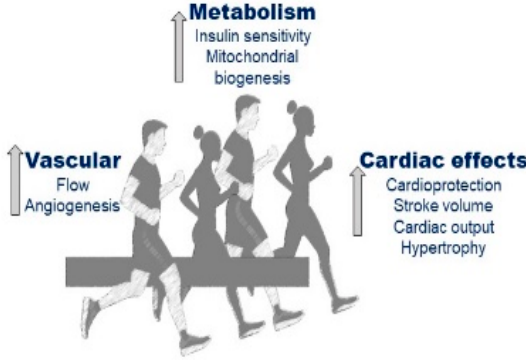
Figure 5. Putative e ff ects of exercise on the cardiovascular system.